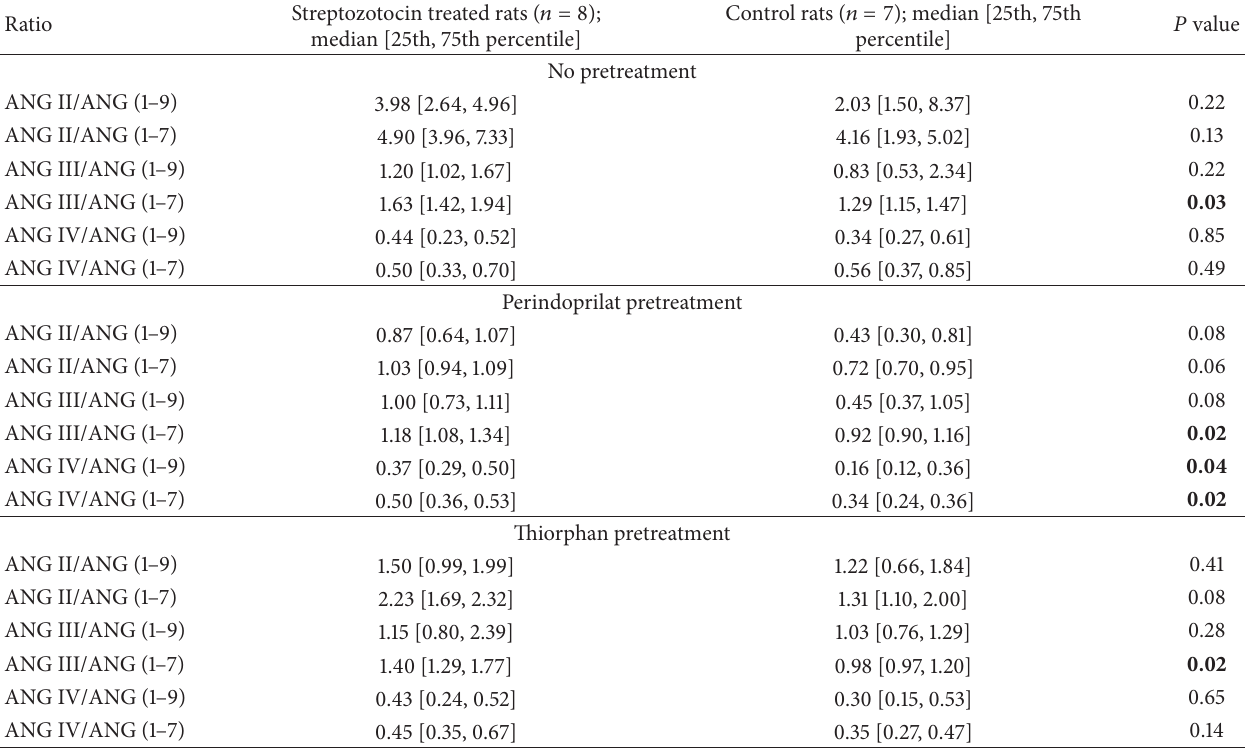
Table 4: Ratios of concentrations of the products of classical and alternative pathways of exogenous ANG I (1 𝜇 M) metabolism by aorta fragments of streptozotocin and saline treated animals (median [25th, 75th percentile]). 𝑃 values are from Kruskal-Wallis nonparametric tests.